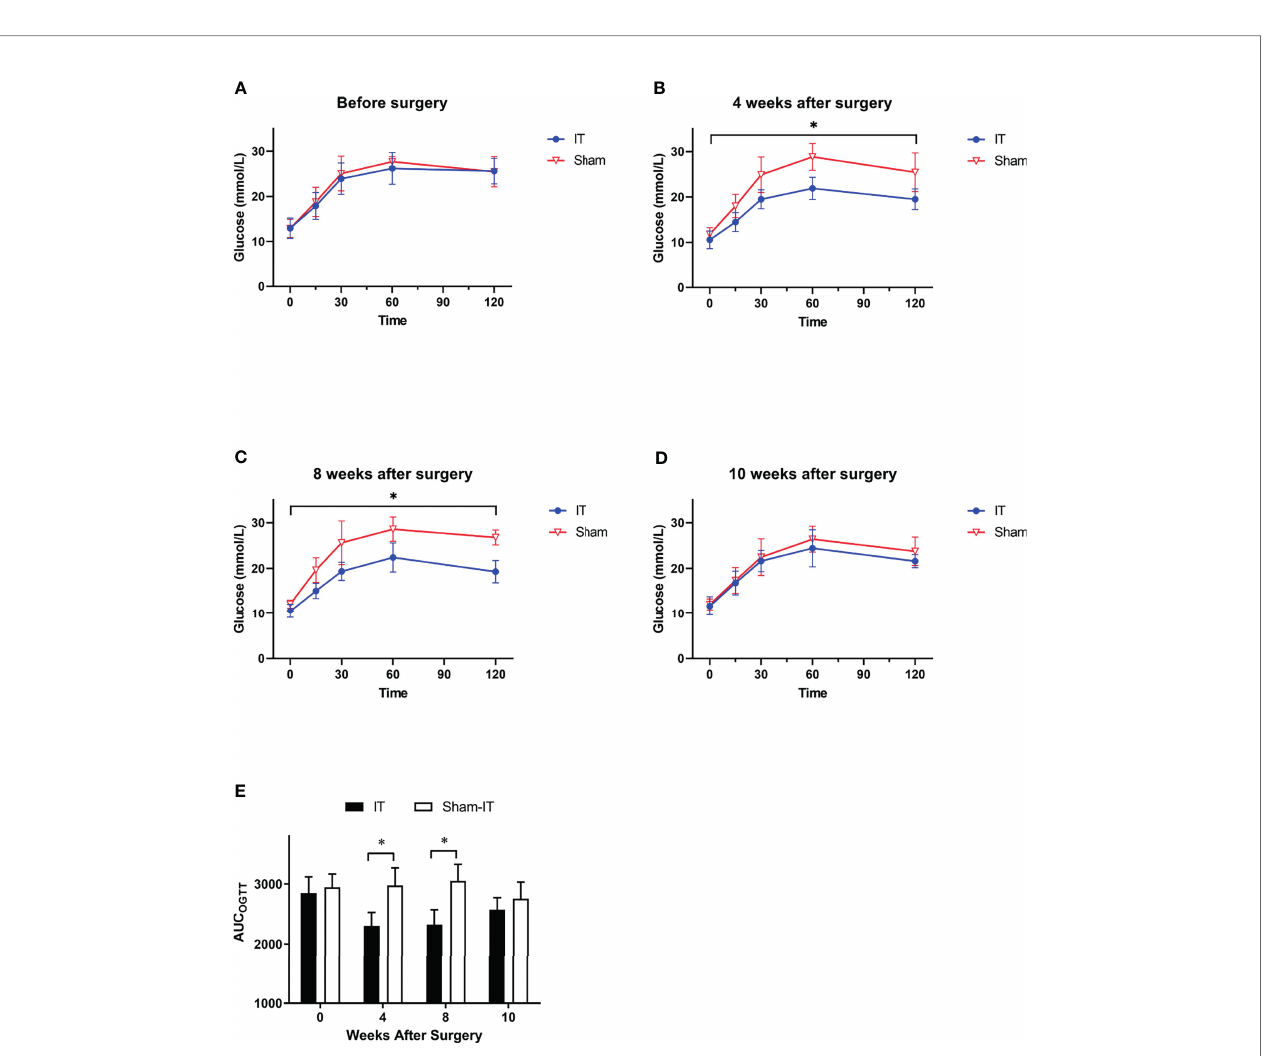
FIGURE 3 | OGTT results at different time points. N = 6 in each group. * p < 0.05. (A) OGTT before surgery. No difference was shown between IT and sham groups (two-way ANOVA: p = 0.569). (B) OGTT at 4 weeks after surgery. Glucose level following oral gavage was signi fi cantly lower in IT group (two-way ANOVA: p = 0.002). (C) OGTT at 8 weeks after surgery. IT rats had signi fi cantly lower glucose level than sham rats (two-way ANOVA: p = 0.001). (D) OGTT at 10 weeks after surgery. IT rats and sham rats showed similar OGTT results (two-way ANOVA: p = 0.269) after administration of GI motility medications. (E) AUC OGTT . Before surgery, there was no difference in AUC OGTT between groups ( t -test, p = 0.497). At 4 and 8 weeks after surgery, AUC OGTT was signi fi cantly decreased in IT group ( t - test, p = 0.001 of both). At postoperative 10 weeks, however, the difference became not signi fi cant ( t- test, p = 0.215).